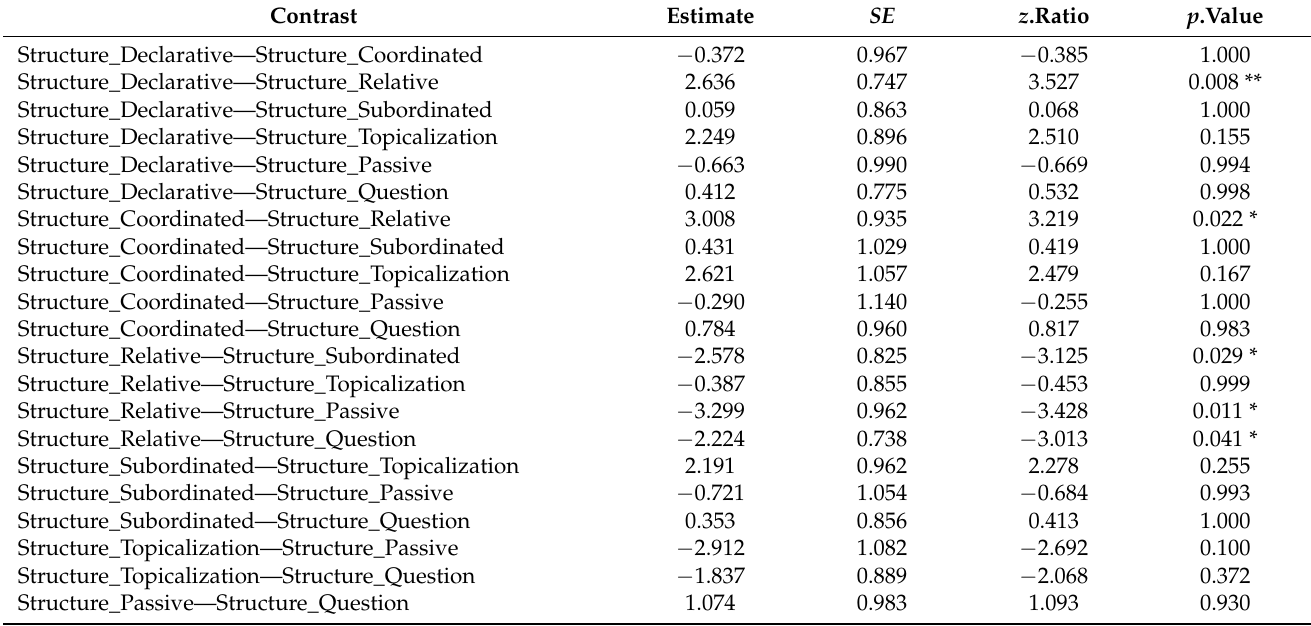
Table A18. Post-hoc tests with a Tukey adjustment showing pairwise contrasts by morphosyntactic structure in Syrian Arabic T2